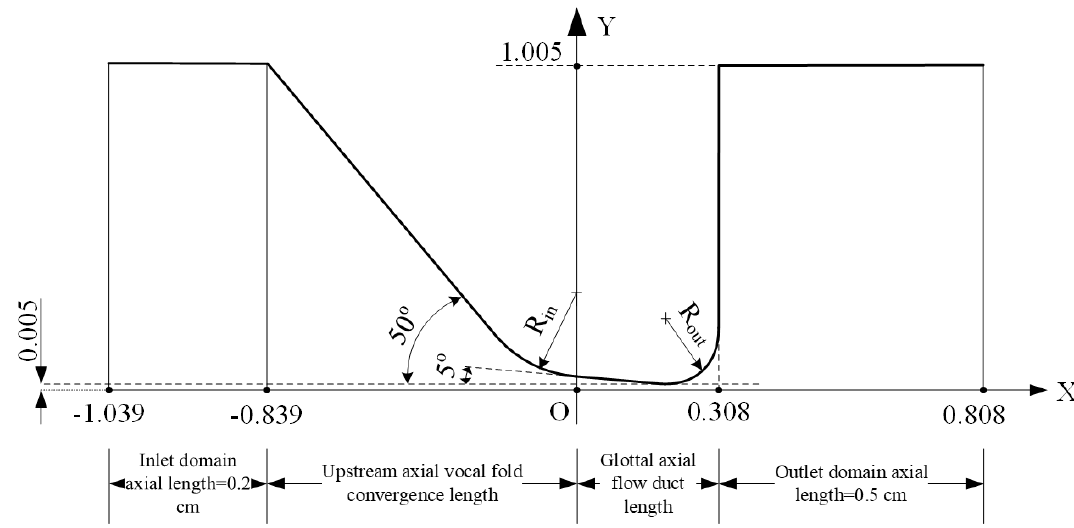
Figure 1. The outline of the glottal configuration for a 0.308 cm vertical (axial) glottal duct length and 0.01 cm minimal glottal diameter for a − 10° (convergent) glottal angle. Distances are in centimeters. R in = 0.15 cm; R out = 0.108 cm.